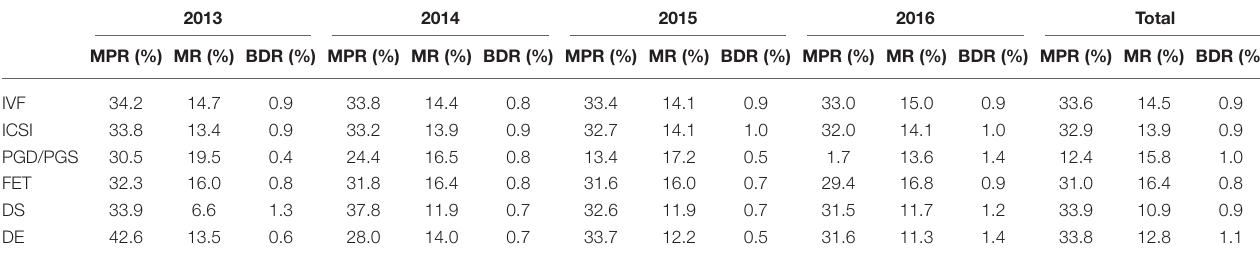
TABLE 4 | Multiple pregnancy, miscarriage and birth defects rate of all kinds of ART in